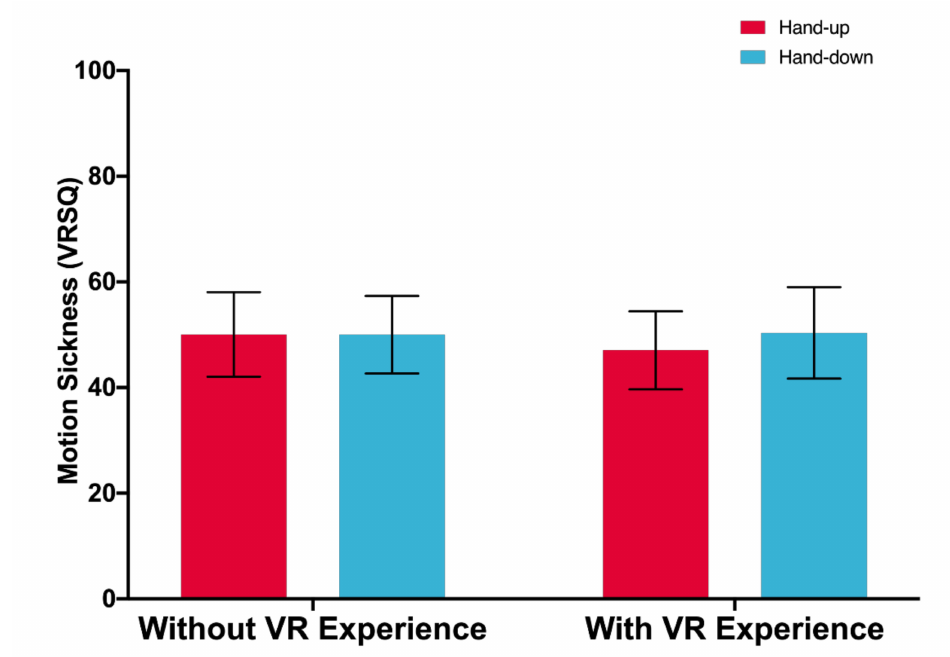
Figure 9. Motion sickness (100 = highest). Error bars represent 95% CI.